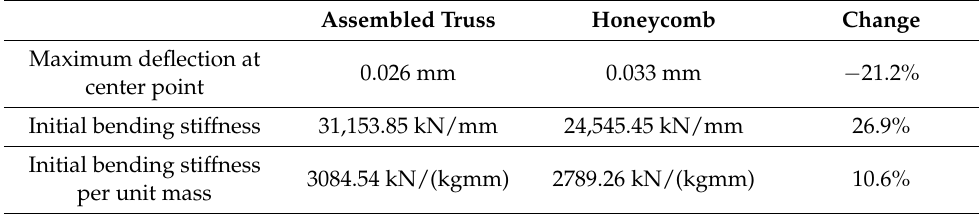
Table 4. Comparison of analysis results for assembled truss and honeycomb core panel.